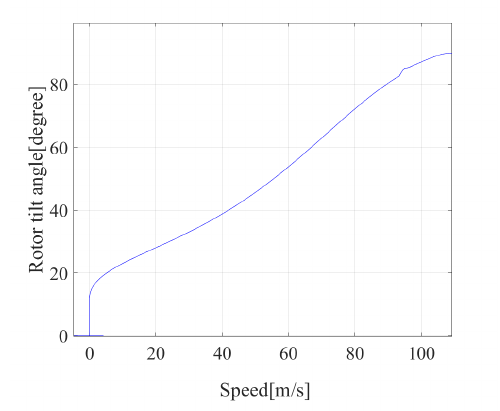
Fig. 14. Curve of transition corridor of this algorithm under no wind disturbance.